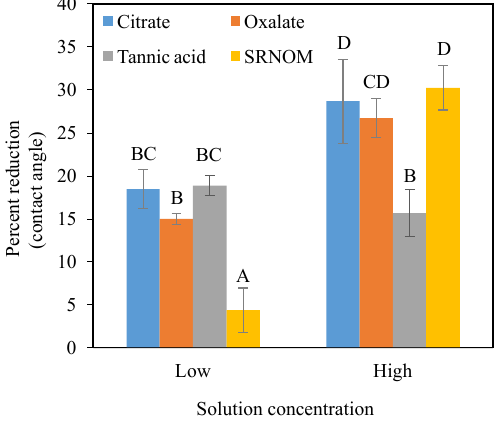
Figure 6. Percent reduction in contact angle from the control (NaCl + HNS) (group A), changes at stable time (90s), for plant exudates (citrate and oxalate), and soil components (tannic acid and organics: Suwanee River natural organic matter, SRNOM), and sta- tistical analysis for t -test significant differentiations. Note: averages graphed and associated error bars represent 1 standard deviation, and values not connected by same letter are significantly different.